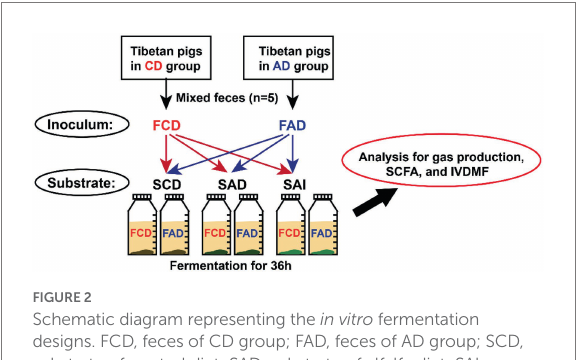
FIGURE 2 Schematic diagram representing the in vitro fermentation designs. FCD, feces of CD group; FAD, feces of AD group; SCD, substrate of control diet; SAD, substrate of alfalfa diet; SAI, substrate of alfalfa